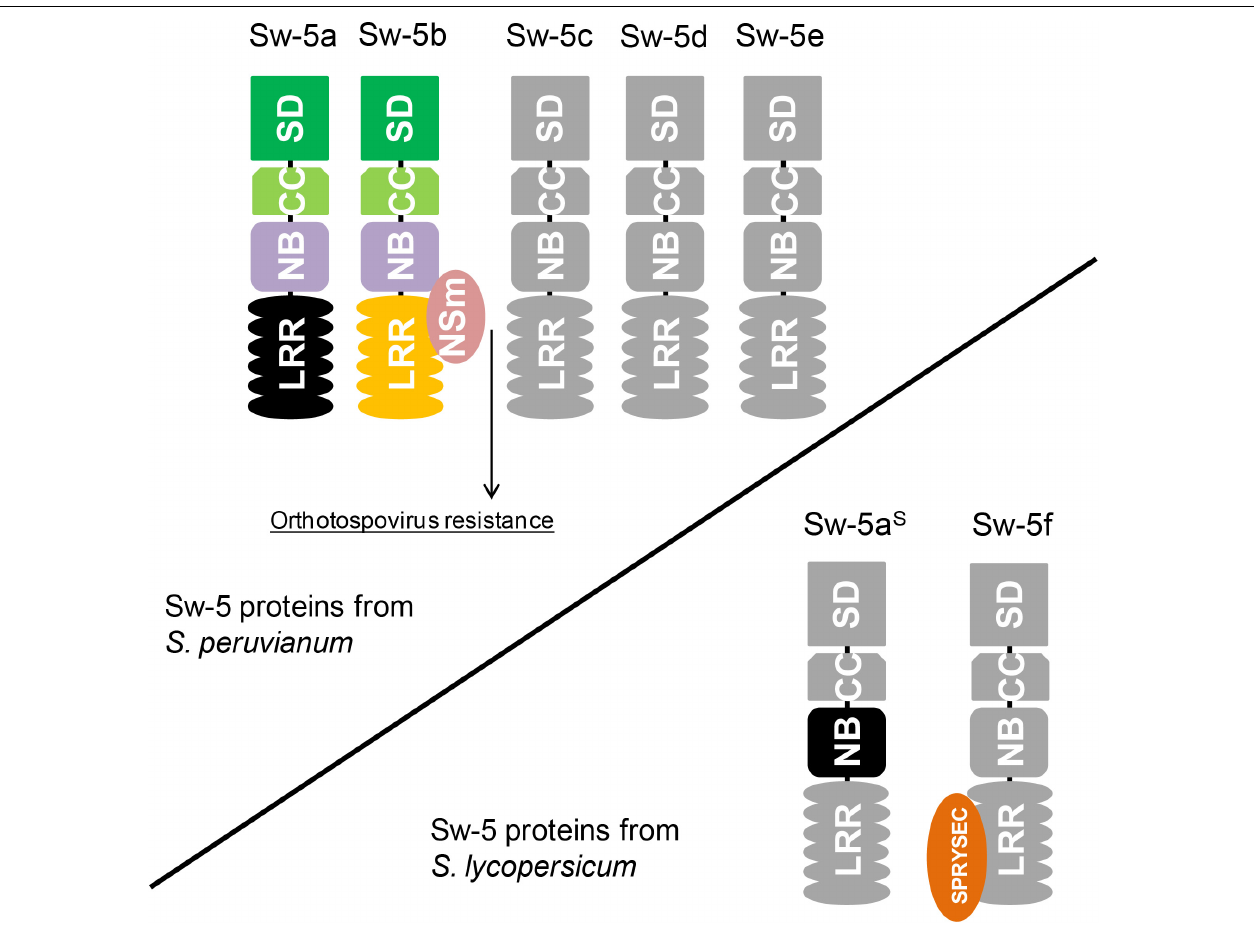
FIGURE 2 | Topology of Sw-5 proteins encoded by paralogs from the Sw-5 gene cluster and orthologs collected from tomatoes susceptible to orthotospoviruses. The upper schematic encompasses the Sw-5 proteins of S. peruvianum . So far, there are only functional studies on Sw-5a and Sw-5b. The latter directly interacts with NSm (orthotospovirus cell-to-cell movement protein), which activates orthotospovirus resistance. On the contrary, Sw-5a is unable to recognize NSm as avirulence (avr)-determinant. The lower schematic shows two Sw-5 proteins found in tomato cultivars susceptible to orthotospoviruses. The most conserved homolog of Sw-5a and Sw-5b, named Sw-5a S , contains a mutation in its nucleotide-binding (NB) domain that halts hypersensitive response (HR) triggering. Apart from this, Sw-5a S cannot recognize NSm as avr-determinant. Sw-5f has been first reported interacting with an effector (SPRYSEC-19) of nematode Globodera rostochiensis that inhibits HR triggered by several resistance